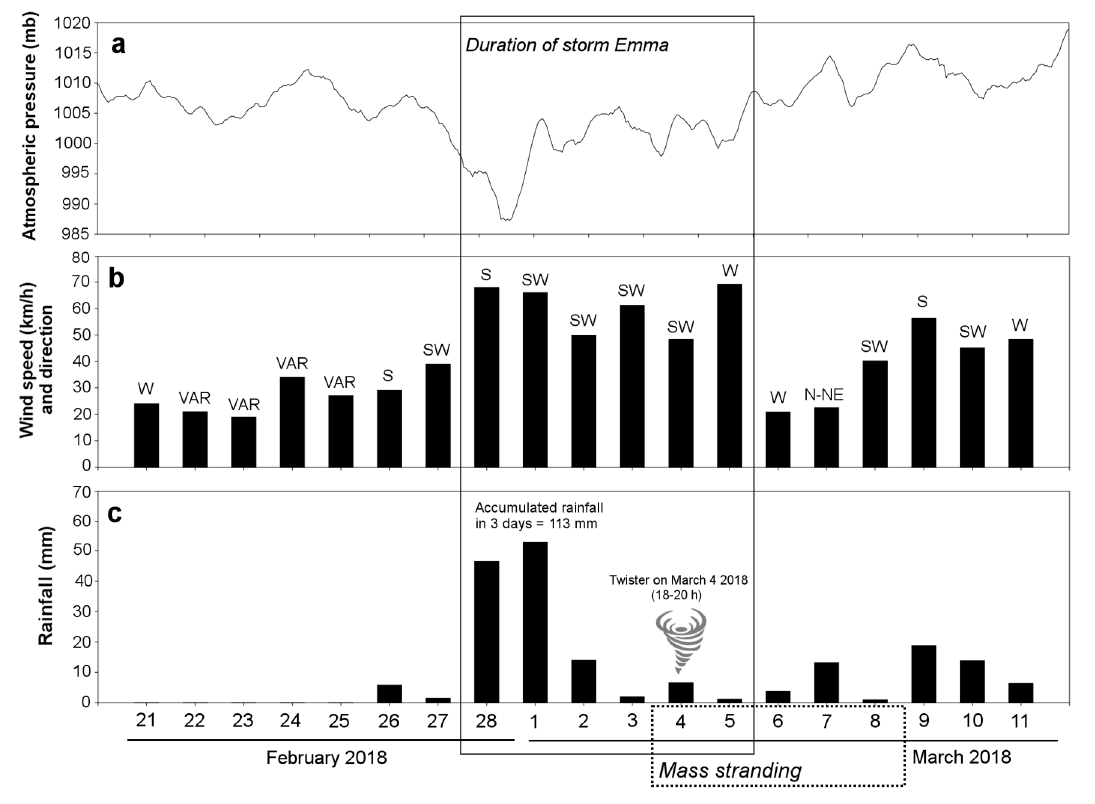
Figure 6. Climatic variables before and after the mass stranding of marine benthic animals: ( a ) Atmospheric pressure; ( b ) wind speed and wind direction; ( c ) daily rainfall.